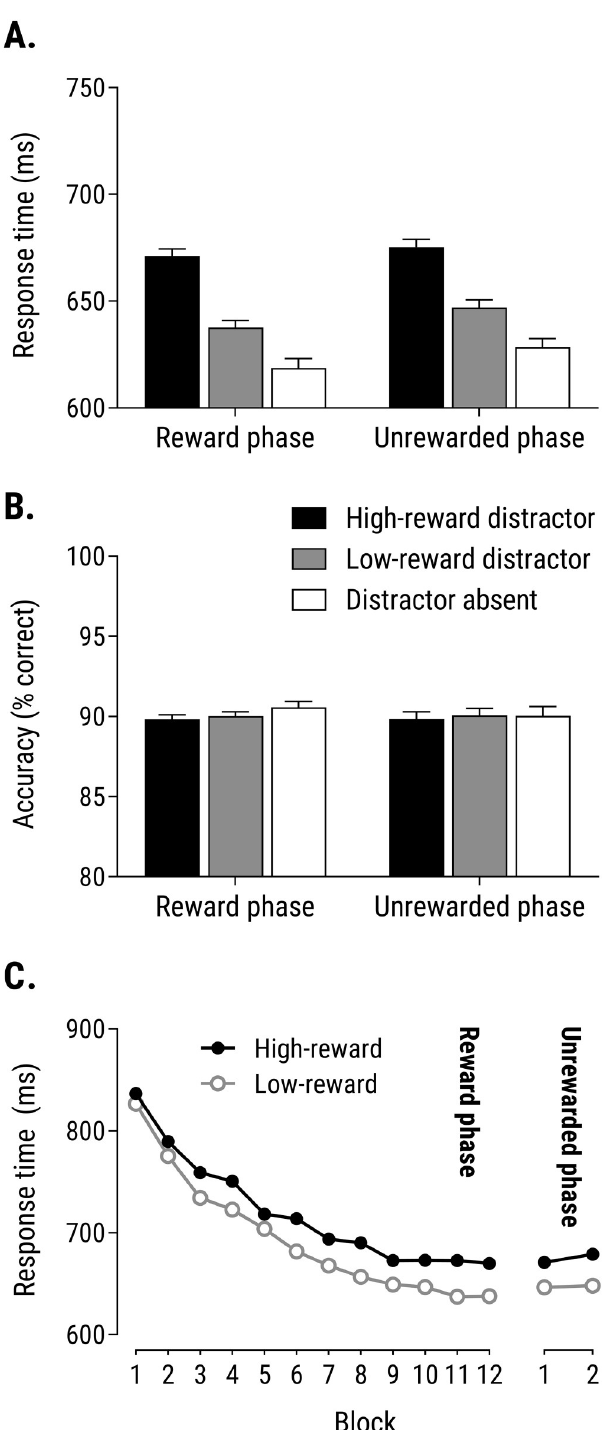
Fig 2. (A) Mean response time and (B) accuracy from the final two blocks of the reward phase and the two blocks of the unrewarded test phase as a function of distractor type (high reward, low reward and distractor absent). Error bars represent within-subject standard error of the mean [38]. (C) Mean response time for trials with a high- or low-reward distractor across the 12 blocks of the reward phase (left-hand section), and the 2 blocks of the unrewarded phase (right-hand